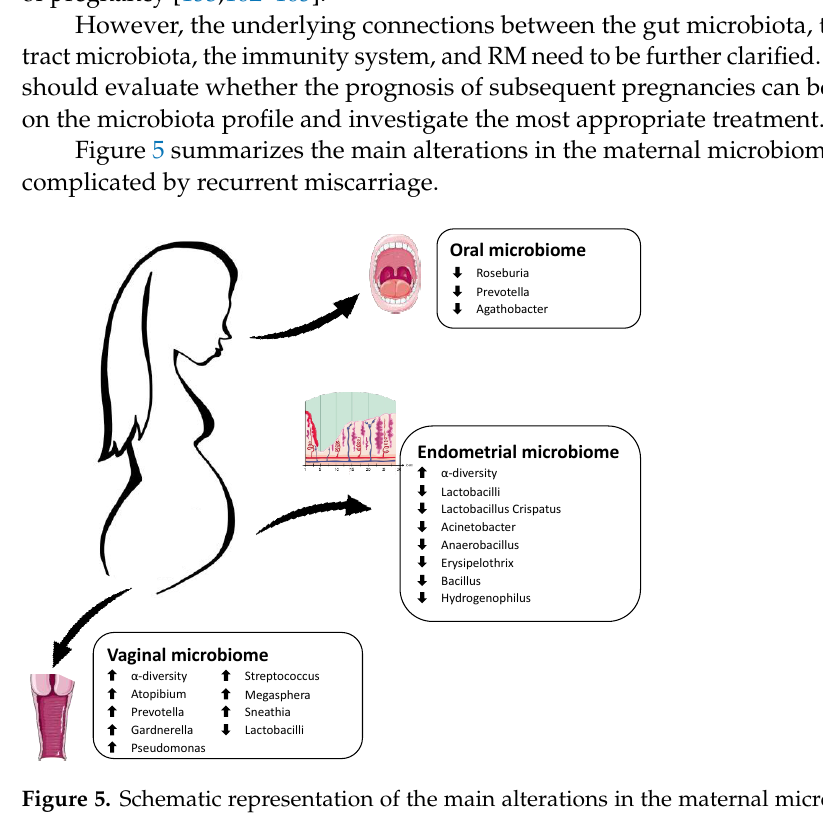
Figure 5. Schematic representation of the main alterations in the maternal microbiome in women suffering from recurrent miscarriage. The Figure was partly generated using Servier Medical Art, provided by Servier, licensed under a Creative Commons Attribution 3.0 unported